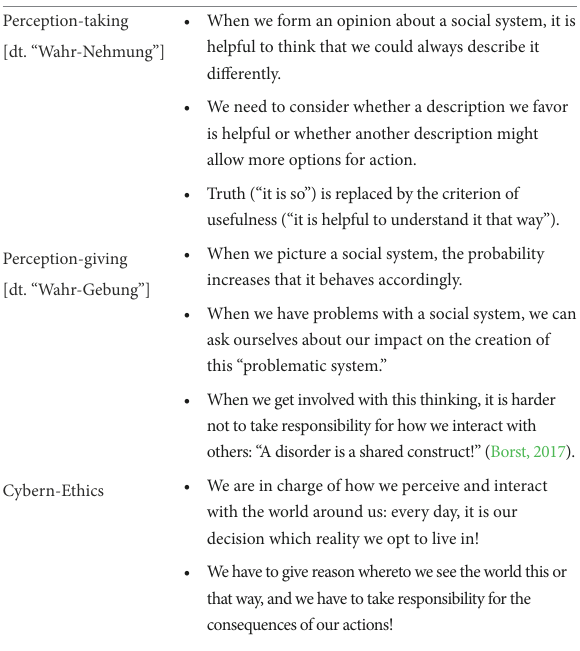
TABLE 1 Radical constructivism and Cybern-Ethics (von Förster and Ollrogge, 2008; Schweitzer et al., 2020; Hunger, 2021). Process qualities Therapeutic